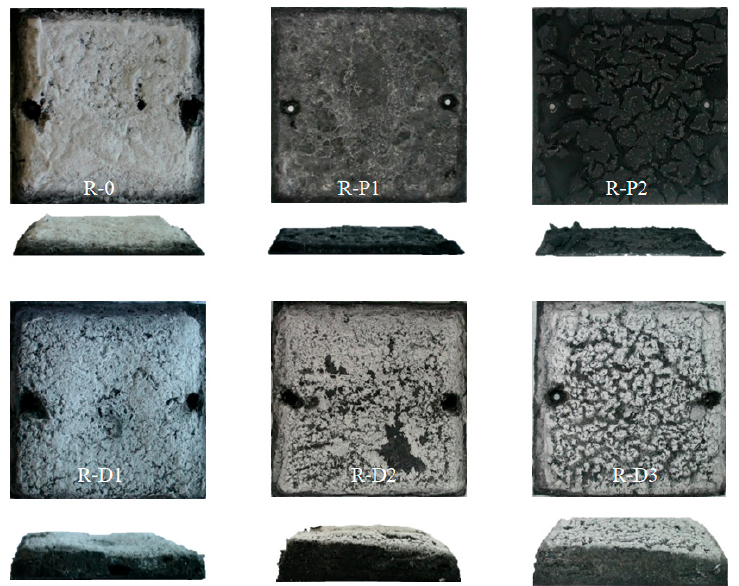
Figure 6. Digital images of intumescent coatings with CNTs or PER-CNTs after the furnace test. On the other hand, a foaming process of the R-D3 coating was not disturbed by CNTs located in the PER-CNTs-3 solid dispersion, but the observed increment of the steel substrate temperature (vs. R-0; Figure 2) was resulted by the high thermal conductivity of the solid dispersion. This sample contained the highest amount of CNTs (in relation to all the tested systems); however, CNTs were located in the PER particles (with the lower volumetric concentration in relation to PVAc). Perhaps, only in this material (PER-CNTs-3), a CNT percolation threshold was achieved, because shapes of the thermal curves were quite similar only for R-0, R-D1, and R-D2 coatings (>550 ◦ C). Nevertheless, finally, the TIT values for all the R-D-type samples were markedly higher in comparison with R-0. Interestingly, this parameter values were almost the same for the PER-CNTs-based systems containing the lowest (R-D1; 28.7 min) or the highest doses of CNTs (R-D3; 28.8 min). On the other hand, the longest insulation time was noted for R-D2 (30.0 min), but this system reached a medium IF value (17.9 a.u.) in relation to R-D1 (17.6 a.u.) and R-D3 (20.0 a.u.; Table 2). This shows that CNT content in the PER-CNTs solid dispersions positively affects the foaming process (a linear dependence; +10.1 a.u. for R-D3 vs. R-0) and thermal insulation features of the coatings (non-linear association; +4.6 min for R-D2 vs. R-0). These differences are caused by two main factors: a heating rate of the whole coating layer, as well as heat transfer by the layer (from fire to steel substrate). It was described that